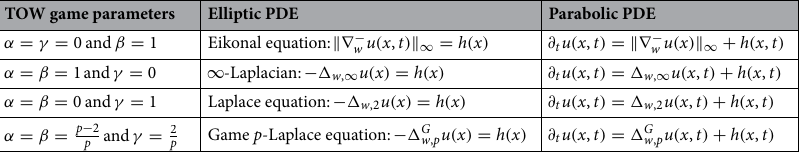
Table 1. A large class of PDEs on graphs recovered from (8)–(9), which are obtained by taking particular parameter values in the TOW games (5)–(6).